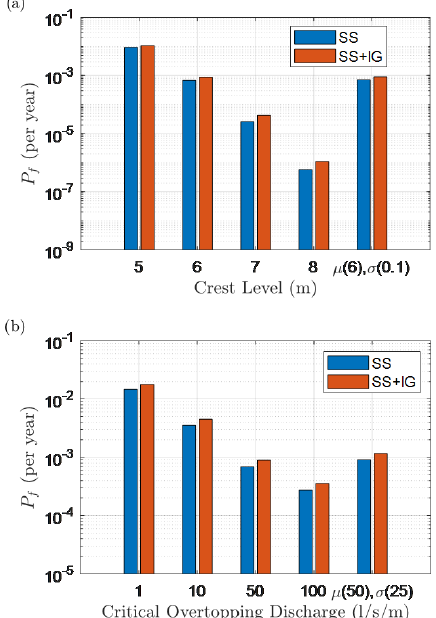
Figure 10. Annual failure probabilities for the two scenarios con- sidered for the following: (a) different dike crest levels with a fixed critical overtopping discharge of 50Ls − 1 m − 1 and (b) different critical overtopping discharges with a fixed crest level of 6m + NAP and dike slope of 1 :